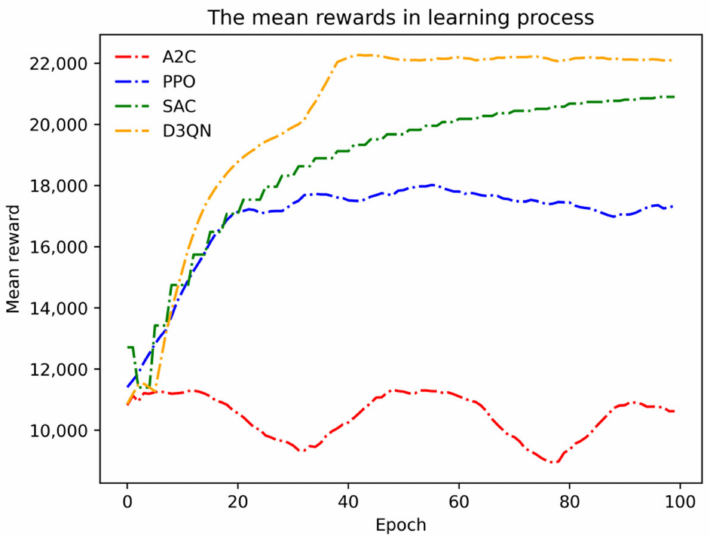
Figure 6. Mean reward of the agent when training with different reinforcement learning